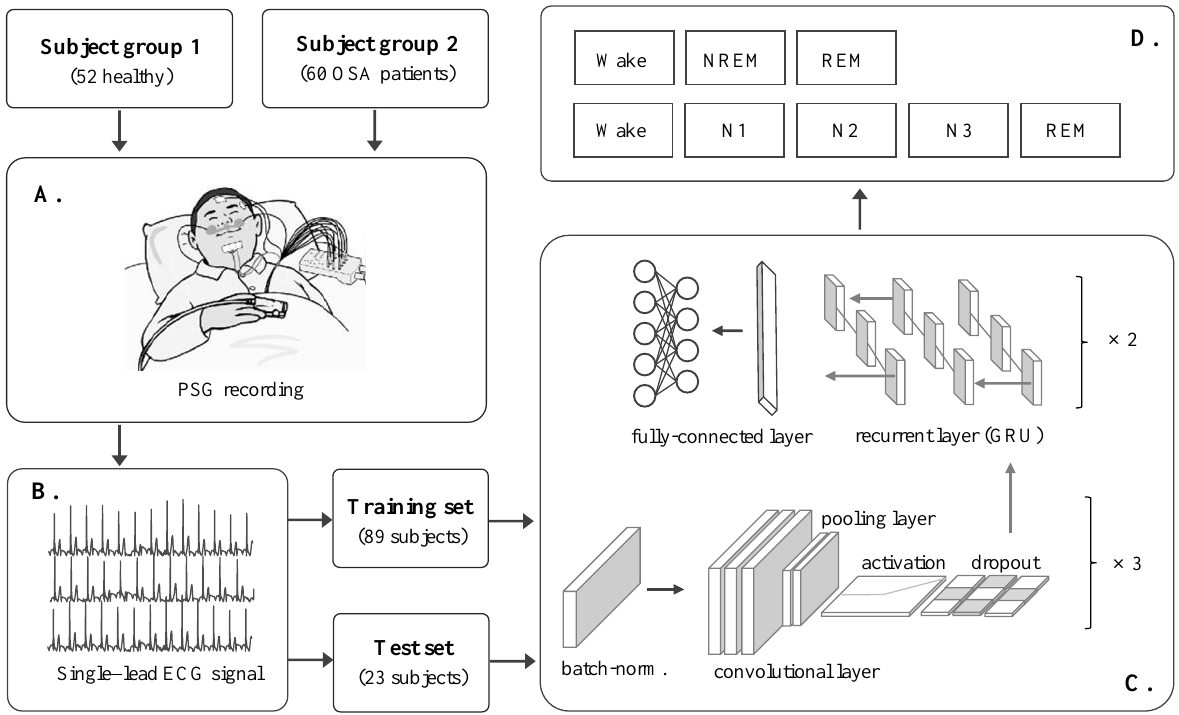
Figure 1. Schematic diagram of this study. ( A ) Study population and PSG study, ( B ) ECG dataset, ( C ) DCR model, and ( D ) target sleep stages.